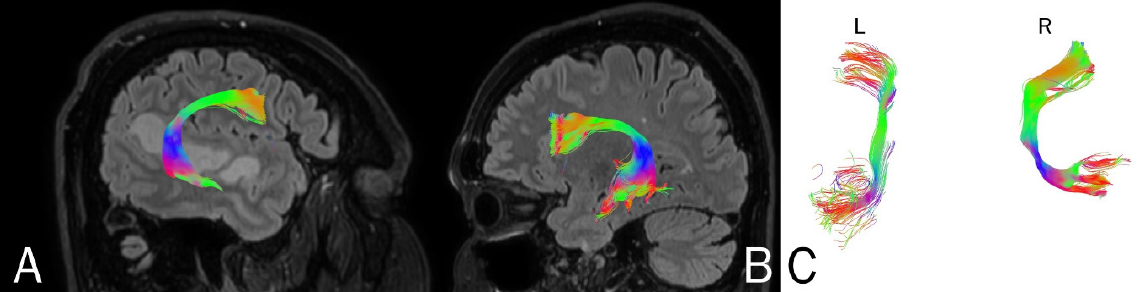
Figure 6. Anatomy of the patient’s arcuate fasciculus (AF) at 3 months following stroke. ( A ) right hemisphere, ( B ) left hemisphere, ( C ) comparison of left and right axial plane of the AF.